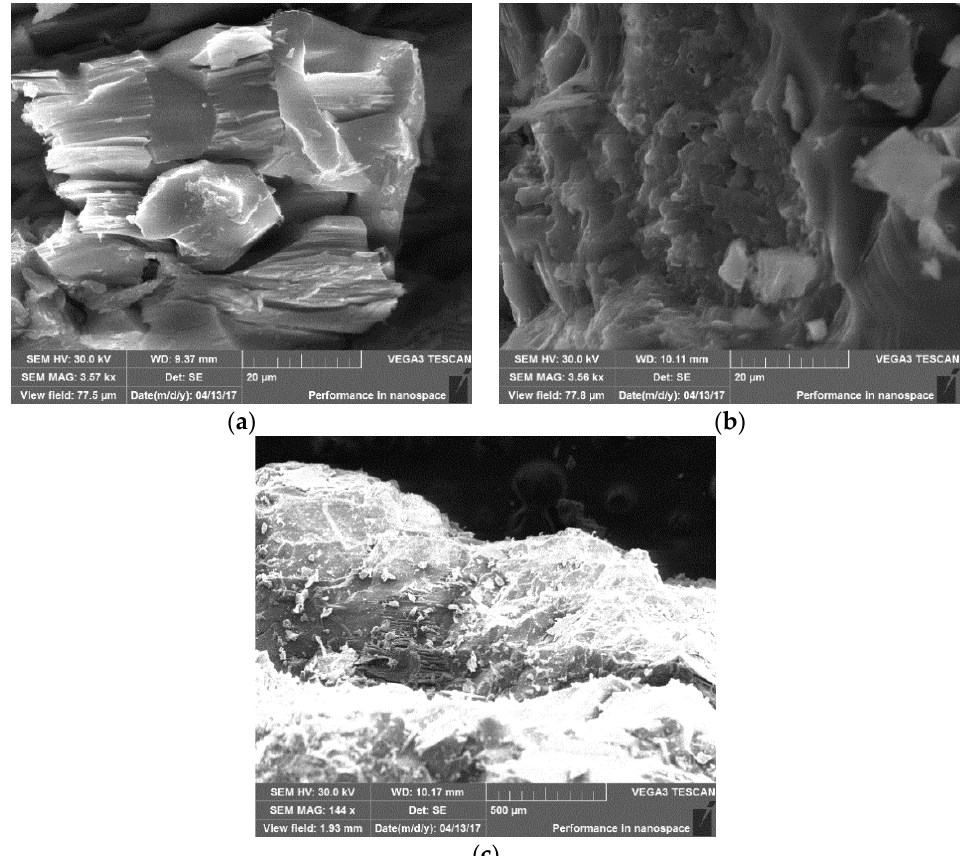
Figure 12. SEM images of G4 tonalite specimens under di ff erent scales: ( a , b ) G4, under 20 µ m; ( c ) G4, under 500 µ